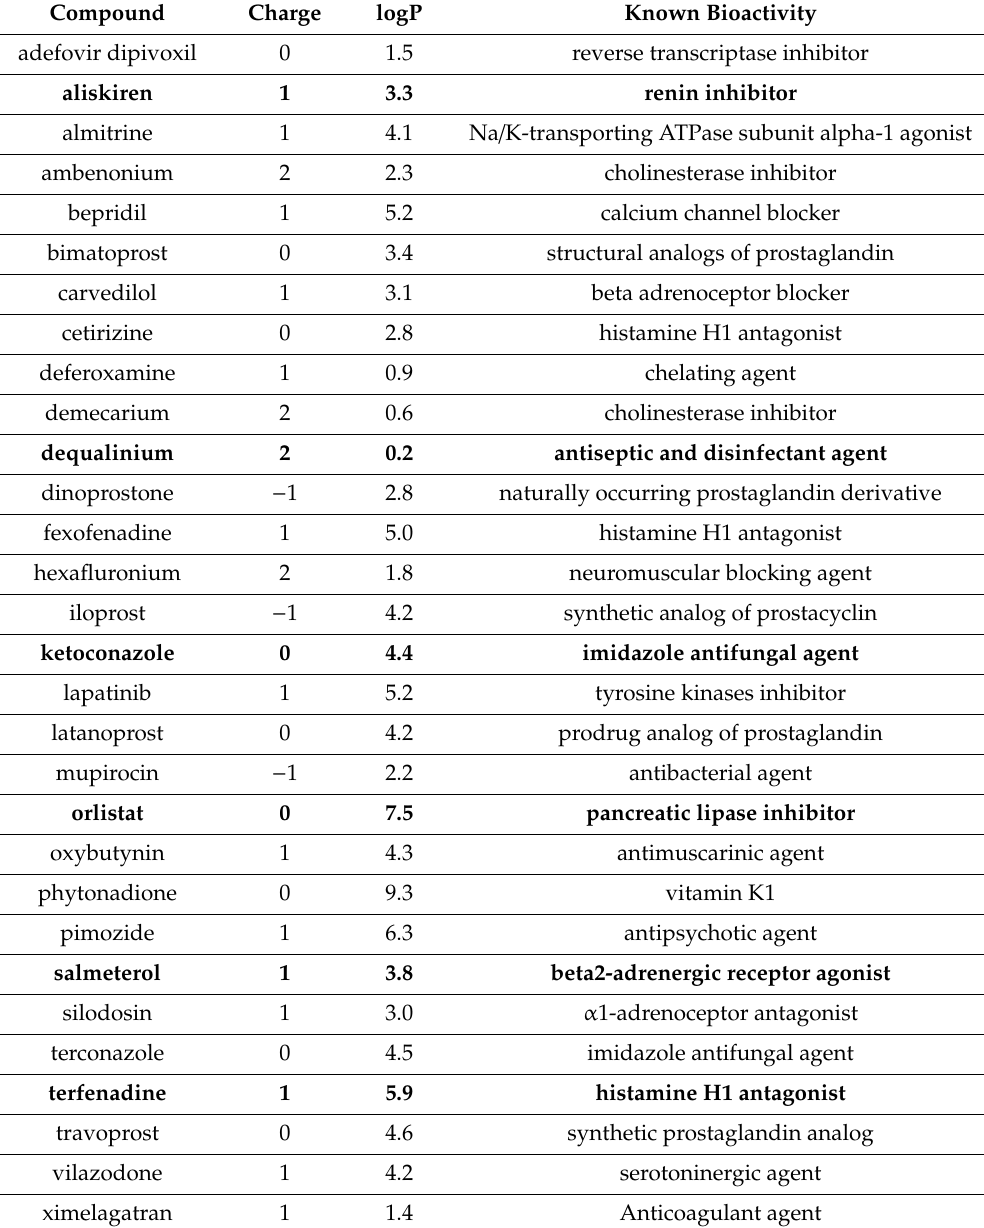
Table 3. Top ranked 30 marketed drugs among which 6 promising ligands (in bold) were selected and tested. LogP values and bioactivities were taken from DrugBank